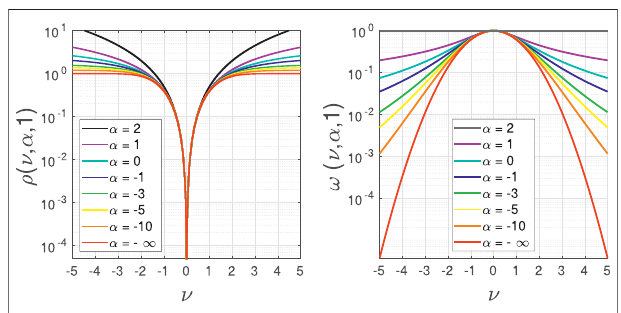
FIGURE 3 | The logarithmic representation of the adaptive loss kernel and its weight function for a multiple values of the shape parameter α . It is clearly visible that the differencebetween alphas smaller than -10 is